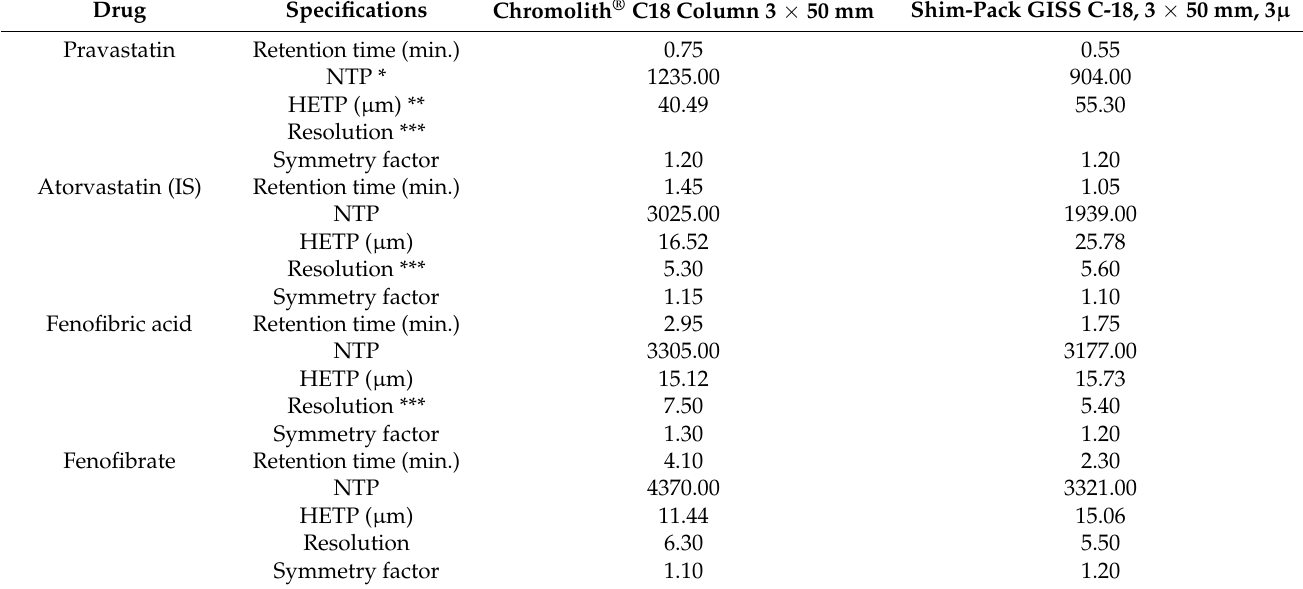
Figure 2. Complete resolution of ( a ) Fenofibrate, ( b ) Fenofibric acid, ( c ) Pravastatin sodium, and ( d ) Atorvastatin by the proposed UHPLC method at flow rate 0.8 mL/min on the UHPLC column ( a ) and the monolithic column ( b ). Table 1. Chromatographic specifications by the use of monolithic and particle-packed columns.